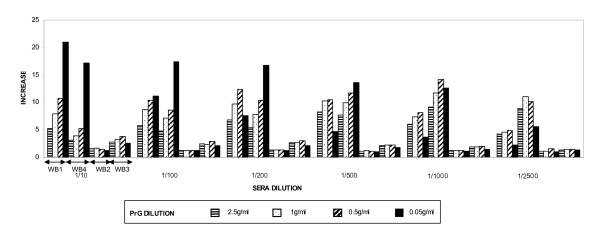
Increase rate (S2/S1) in the optical density reading of the ELISA with bovine PPD and protein G in WB1 and WB4 (immunized with M. bovis), WB2 (M. avium paratuberculosis) and WB3 (M. avium).